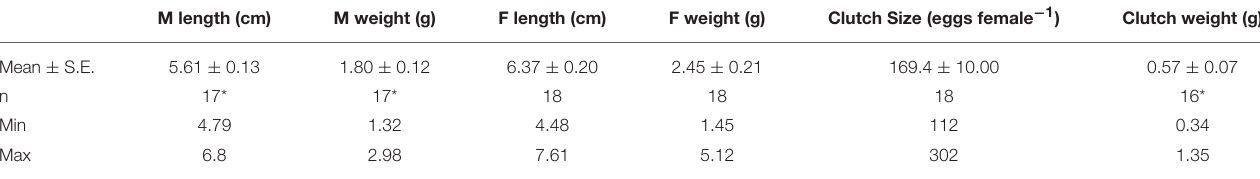
TABLE 1 | Background information on parents’ sticklebacks Gasterosteus aculeatu s and their clutches used in this study. M length (cm) M weight (g) F length (cm) F weight (g) Mean ± S.E.